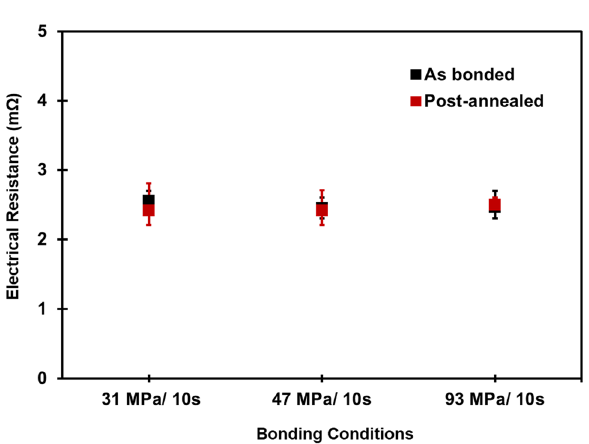
Figure 4. Ion FIB and EBSD images of the Kelvin microbumps bonded at 300 °C/47 MPa/10 s after 1000 thermal cycles: ( a , c ) as-fabricated and ( b , d ) post-annealed, respectively. It is obvious in ( c ) that cracks propagated along the bonding interface. As the original bonding interface was eliminated, no obvious cracks were detected ( d ). Thus, its electrical resistance was mostly maintained unchanged under thermal cycling.